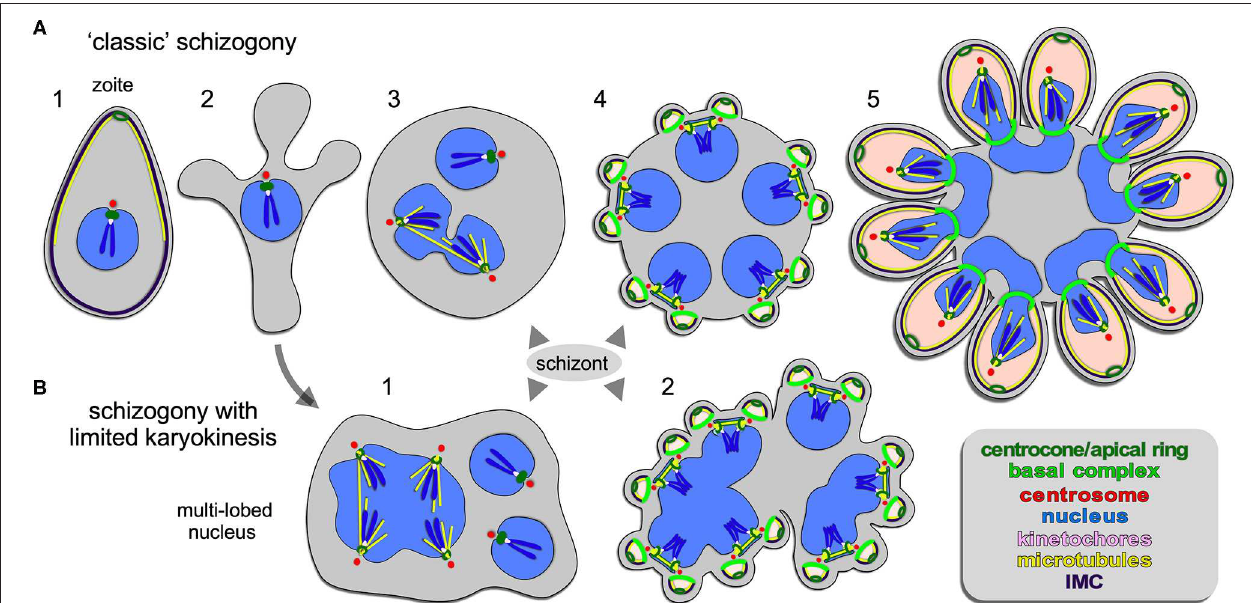
FIGURE 2 | Apicomplexan asexual cell division by schizogony. (A) Schematic representation of progressive cell division steps during “classic” schizogony. The mother’s cytoskeleton (present in 1) is disassembled following successful host cell invasion resulting in a pleomorphic cell (2) before onset of mitosis and karyokinesis, which can be asynchronous (3). Daughter cells bud from the cortex (4/5), positioned by the centrosome anchored at the plasma membrane (4). (B) Schematic representation of phases in the cell division during schizogony with limited karyokinesis as seen during Heamosporidian sprorogenesis. Karyokinesis is inconsistently following each S/M-phase leading to a nuclei population with varying levels of ploidity. Note that nuclear cycles within the same nucleoplasm are similar (1), whereas budding is synchronous for all nuclei and linked to a final round of S/M (2). Note that the number of offspring in both forms of schizogony can reach into the 1000s, which is not represented in the schematics. Chromosome condensation does not occur and the chromosomes are only drawn to convey the principle of spindle pole attachment. Mother cytoplasm represented in gray, daughter cytoplasms in